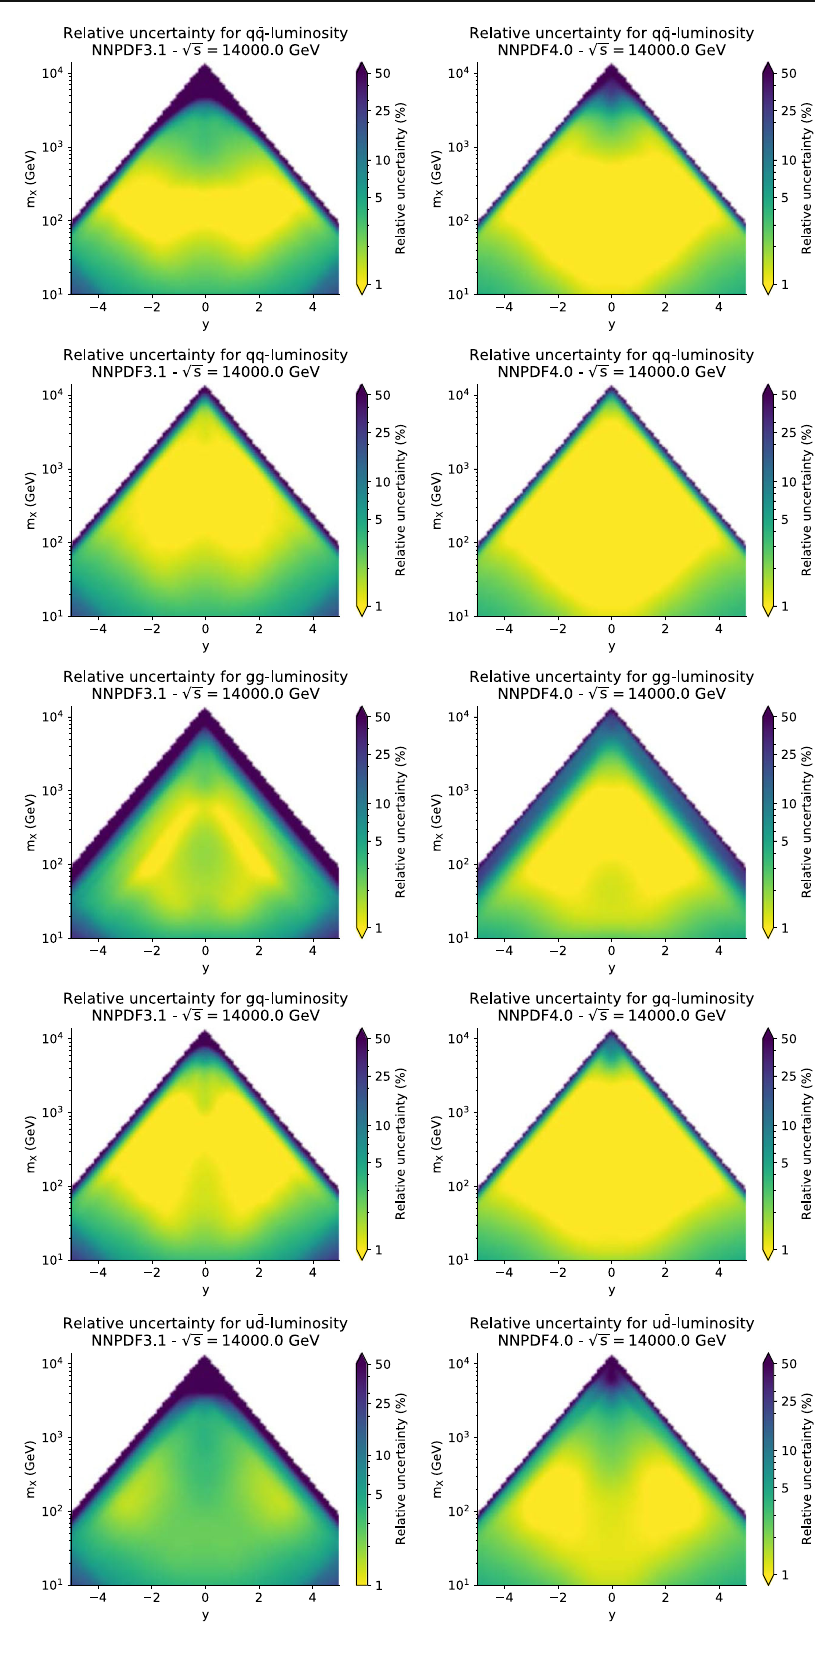
Fig. 59 The relative uncertainty on the parton luminosities of Fig. 58, now plotted as a function of the invariant mass m X and the rapidity y of the final state; the left plots show results for NNPDF3.1 and the right plots for NNPDF4.0; results for the up-antidown luminosity are also shown in the last